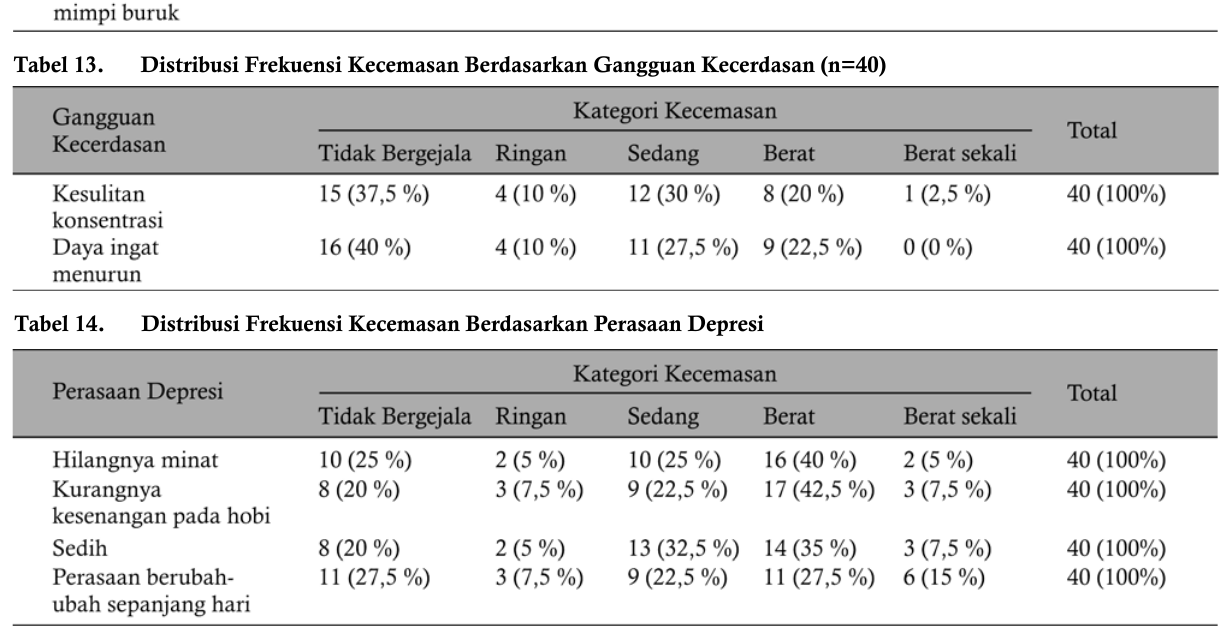
spesifik, lebih dari 60% (gejala ringan s/d berat) yang menunjukkan gejala kesulitan konsentrasi, dan daya ingat menurun (Tabel